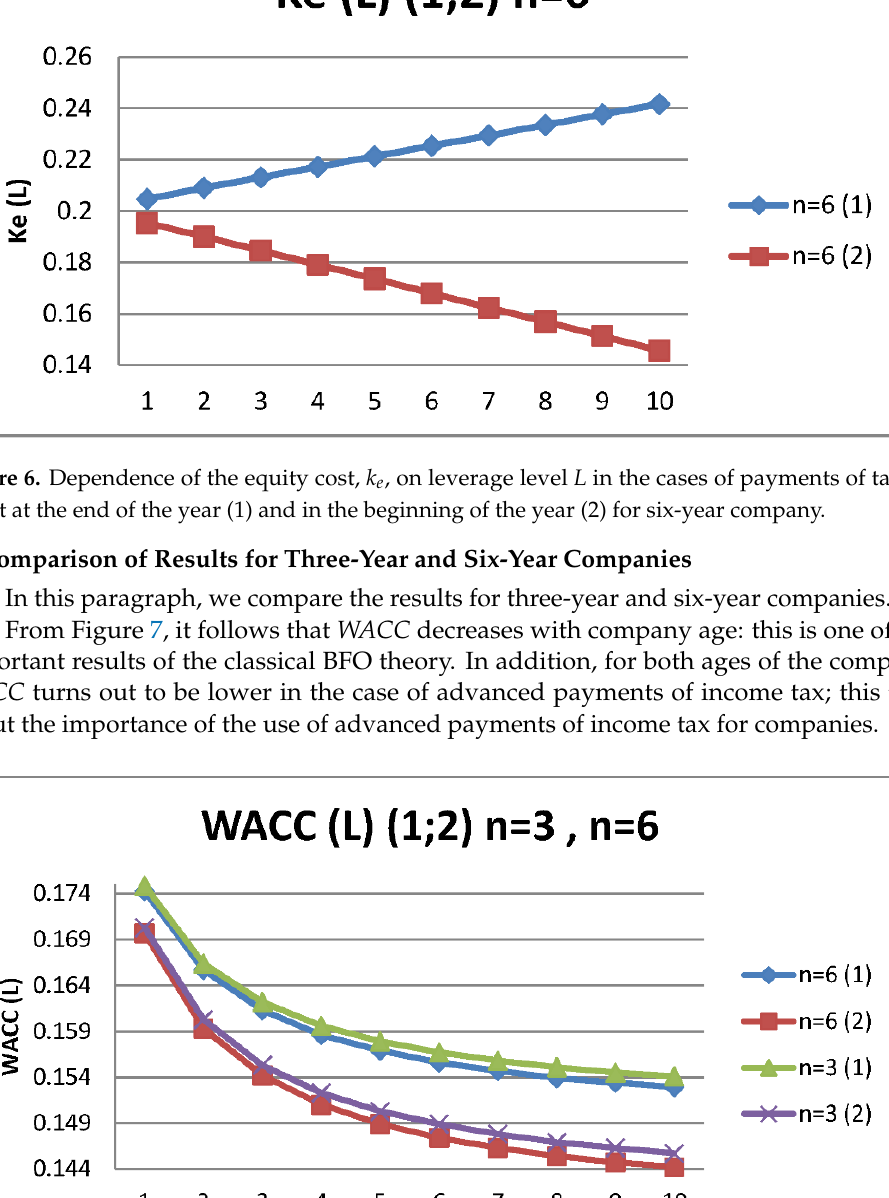
Figure 8. Dependence of the company value, V , on leverage level L in the cases of payments of tax on profit at the end of the year (1) and in the beginning of the year (2) for three-year and six-year companies. From Figure 9, it follows that the equity cost k e increases with leverage level L in the case of payments of income tax at the end of the year and decreases with leverage level L in the case of advanced payments of income tax for both ages of the company. This means the appearance of a qualitatively new effect that can greatly change the company’s dividend policy, because the economically justified amount of dividends is equal to the equity cost. Equity cost k e decreases with company age in both cases: this is one of the important results of the classical BFO theory.